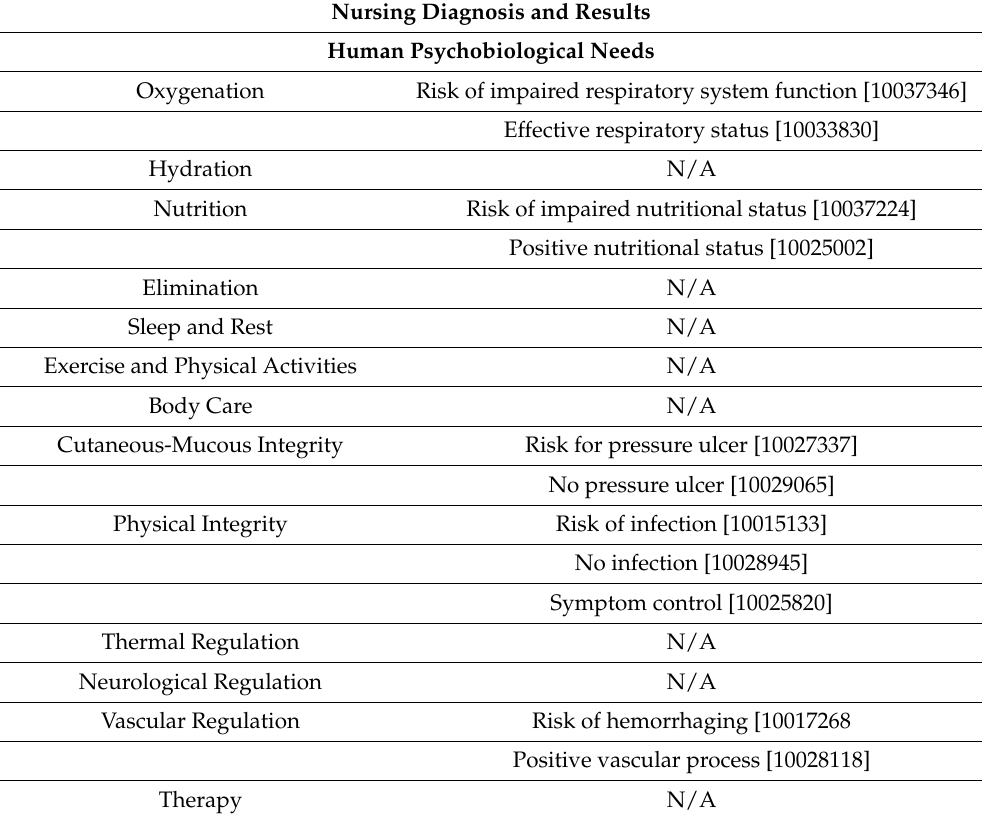
Table 1. Nursing care plan for a newborn in the postoperative period with diagnosed congenital